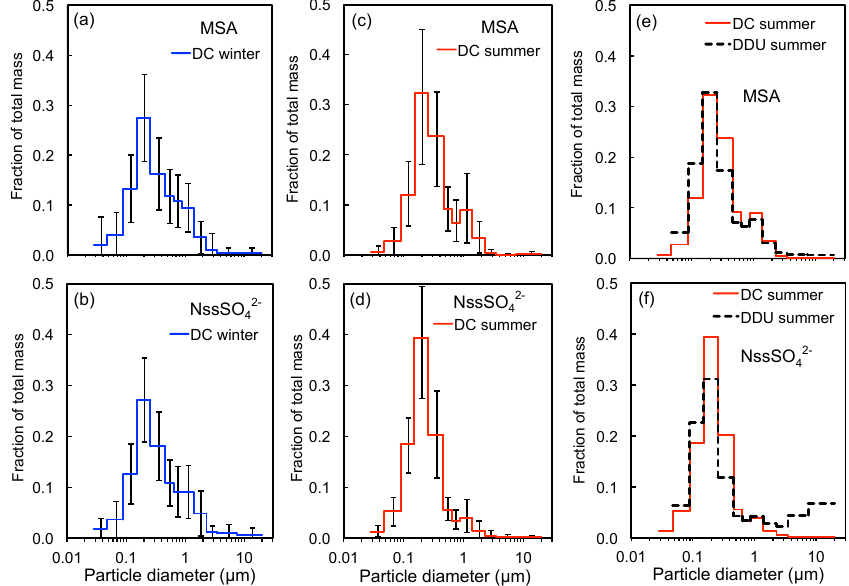
Figure 4. Mean size-segregated mass composition of sulfur aerosol (MSA and non-sea-salt sulfate) at Concordia in winter (a, b) and summer (c, d) , at Concordia and DDU in summer (e, f) . Vertical bars reported in panels (a) – (d) denote sample-to-sample variability. The presence of very large nssSO 4 particles at DDU in summer (dashed black line in panel f ) is due to sulfate from ornithogenic soils present at the site (Jourdain and Legrand, 2002). Note that at DDU the impactor was run using only 11 stages, missing the smallest